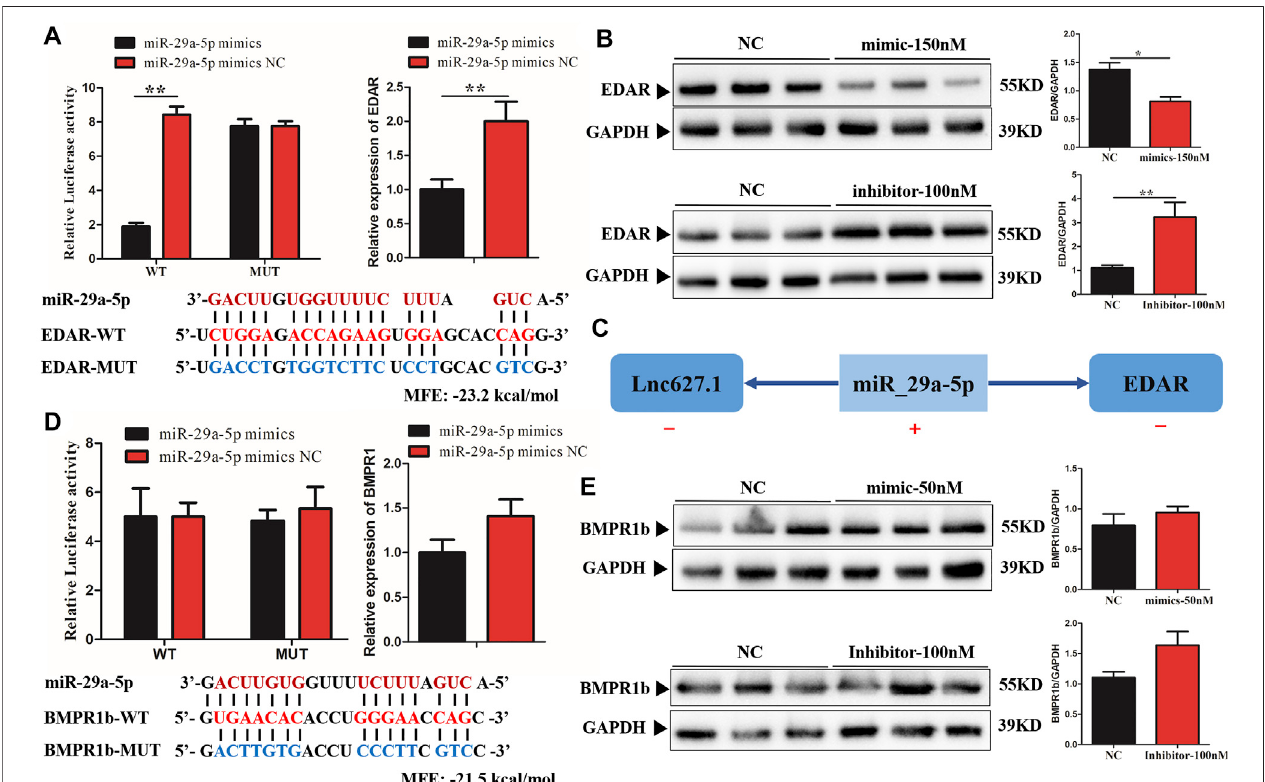
FIGURE 3 | Veri fi cation of miR-29a-5p target binding for EDAR and BMPR1b 3 ′ UTR. (A) Left histogram: luciferase assays were performed in 293-Tcells co- transfected with pMirGLO-EDAR – 5 ′ -UTR-WT/MUT and ssc-miRNA-29a-5p mimics; Right histogram: EDAR mRNA expression detected in fi broblast cells after treatment with ssc-miRNA-29a-5p mimics; (B) EDAR protein expression detected in fi broblast cells following miRNA-29a-5p overexpression or inhibition. (C) The mechanism of ceRNA network expression in lncRNA627.1/miRNA-29a-5p/EDAR. (D) Left histogram: luciferase assays were performed in 293-Tcells co- transfected with pMirGLO-BMPR1b – 3 ′ -UTR-WT/MUT and ssc-miRNA-29a-5p mimics; Right histogram: BMPR1b mRNA expression detected in fi broblast cells after treatment with ssc-miRNA-29a-5p mimics; (E) BMPR1b protein expression detected in fi broblast cells following miRNA-29a-5p overexpression and inhibition. Red letters indicate wild type sites and blue letters indicate mutated sites in the pMir-report luciferase reporter vector. Error bars indicate the mean ± SD of triplicate experiments. * p < 0.05, ** p < 0.01, *** p < 0.001. MFE, minimum free energy.